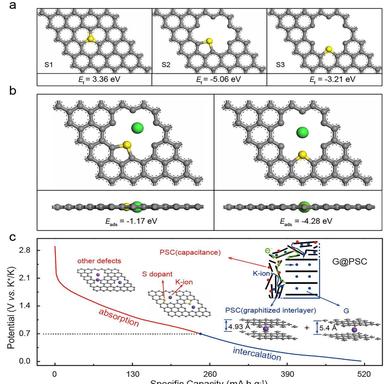
(a) The optimized geometry structure and corresponding Ef for possible S-doped defects (S1, S2, S3). (b) Theoretical simulation for K Eads with different S-doping defective sites (S2 and S3). (c) The detailed K-storage process and K-storage sites of G@PSC at the second discharge process.